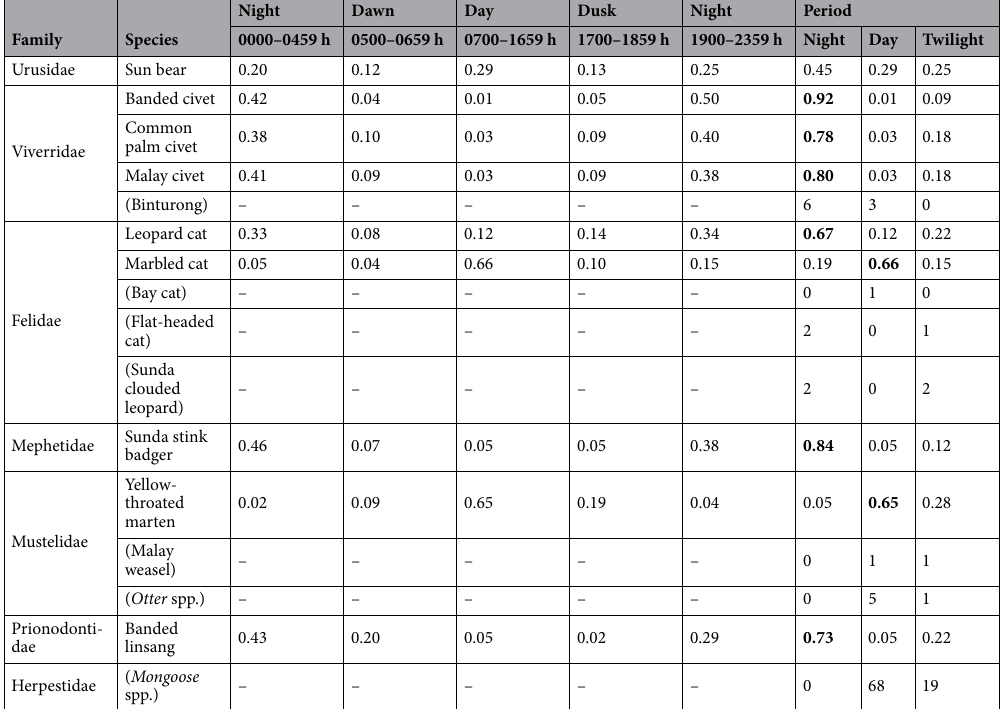
Table 2. The proportion of independent photo-capture of carnivore species during nighttime, twilight, and daytime. Data of species in parenthesis indicate the number of independent photo-capture. All the data are derived from pooled photo-captures of the three study sites. Values in bold letters indicate the significantly most active period of each species.